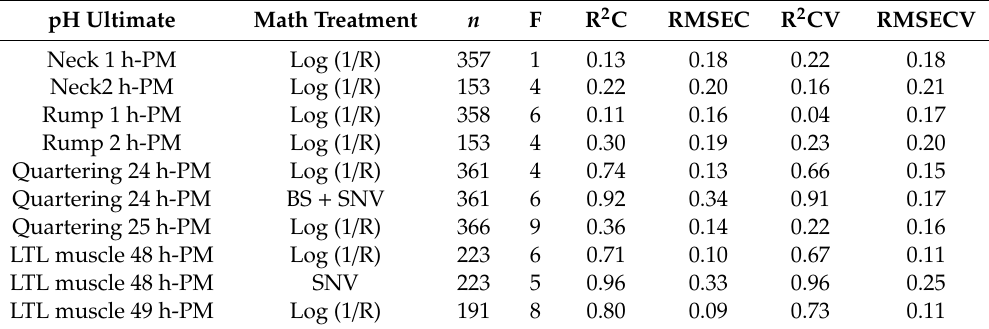
Table 2. Prediction of pH ultimate of beef samples using Vis–NIR